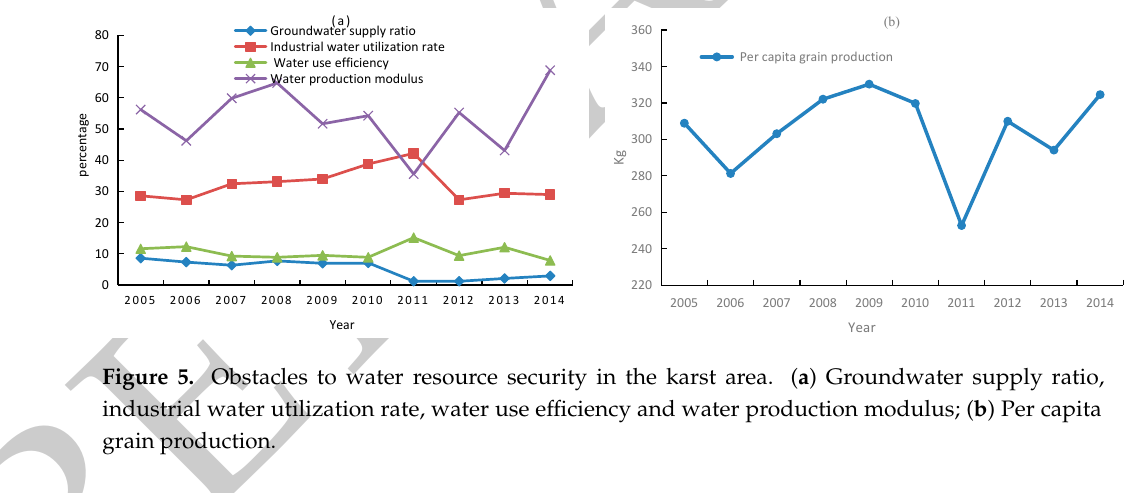
Figure 5. Obstacles to water resource security in the karst area. ( a ) Groundwater supply ratio, industrial water utilization rate, water use efficiency and water production modulus; ( b ) Per capita grain production.